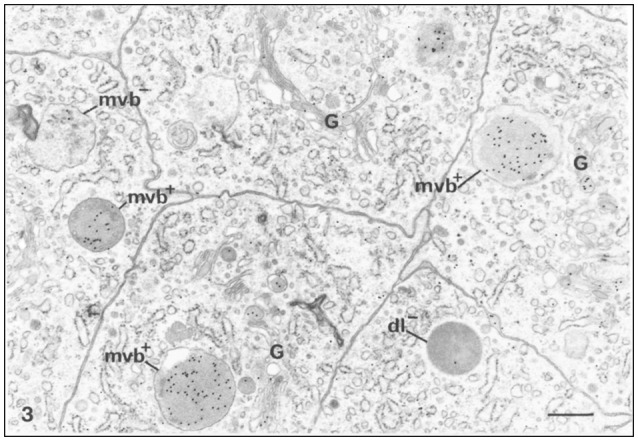
Immunocytochemical preparation illustrating the distribution of gold labeled amelogenin over various compartments of ameloblasts from the secretion stage in mouse incisors. Lysosomes appear variably labeled. Multivesicular bodies are often intensely labeled (mvb+). An unlabeled multivesicular body (mvb−) and an unlabeled dark lysosome (dl−) are shown. The Golgi apparatus (G) shows some labeling by gold particles, × 24,875. Bar = 0.5 μm. Permission to reprint from: Application of High-Resolution Immunocytochemistry To the Study of the Secretory, Resorptive, and Degradative Functions of Ameloblasts by Nanci et al. (1987a).